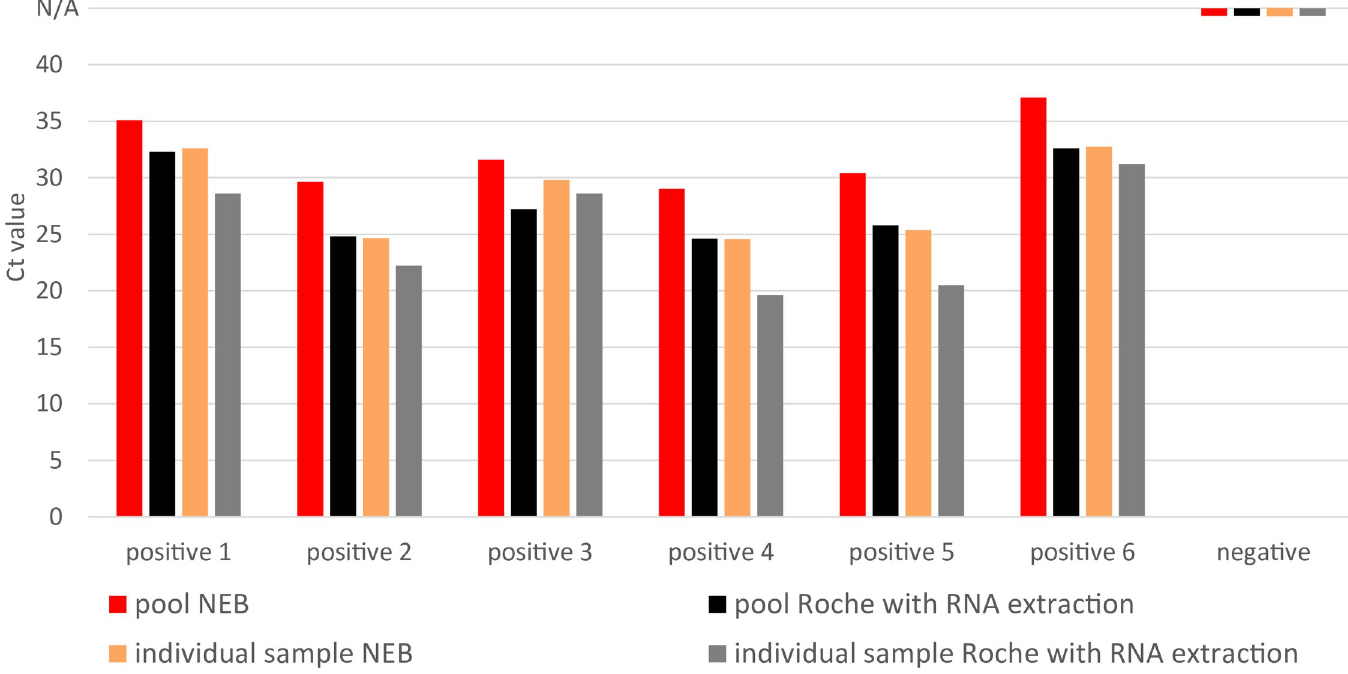
Fig 5. Tests of seven pools of 26 mouthwash samples, which in six cases contain one positive sample. Dashes at N/A show no amplification of the viral target.